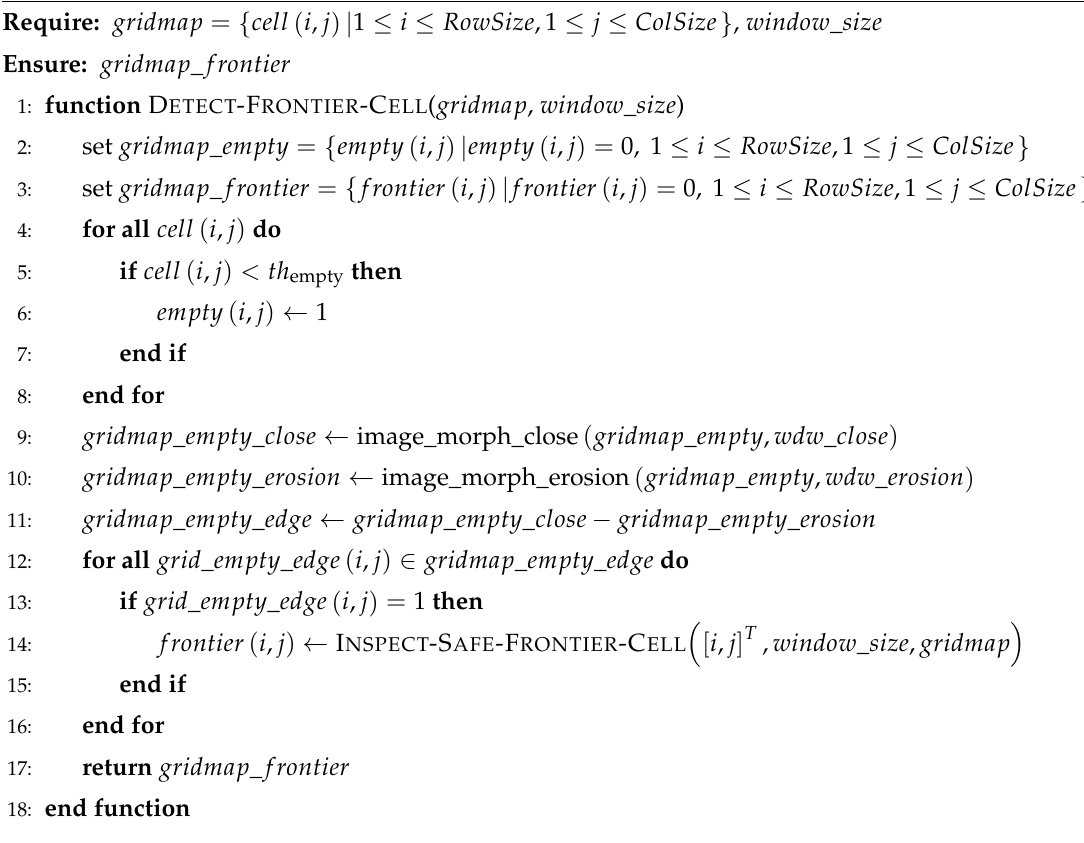
Algorithm 2 Frontier cell